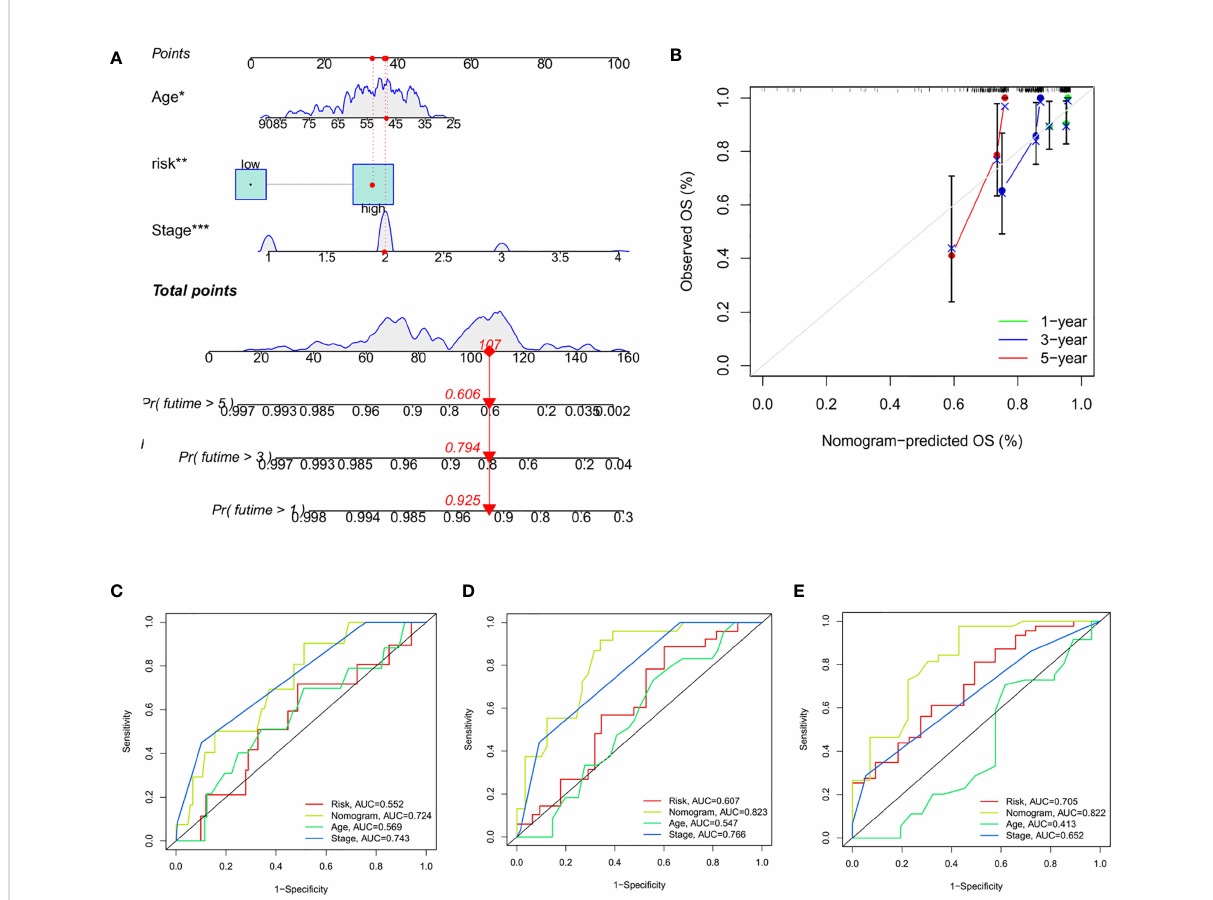
FIGURE 10 Construction and Evaluation of Nomogram Based on CRG_score (A) Nomogram for predicting the 1-, 3-, and 5-year OS of TNBC patients. (B) Calibration curves of the nomogram. (C – E) ROC curves for predicting the 1-, 3-, and 5-year ROC curves in the train, test, and entire sets. The asterisks represented the statistical p value (*P < 0.05; **P < 0.01; ***P <